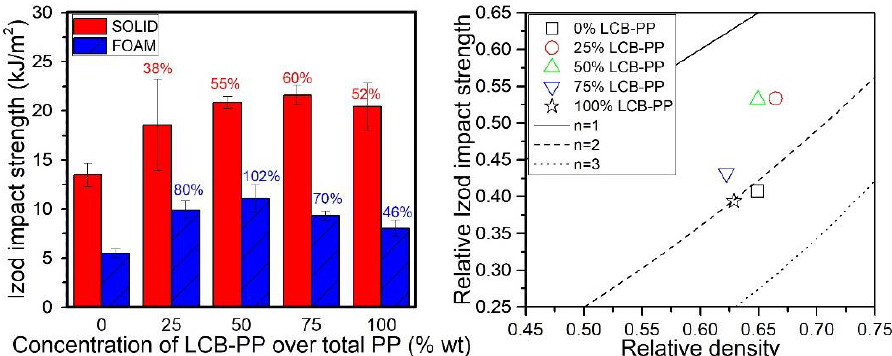
Figure 9. Izod impact strength of solids samples and foams ( left ) and relative Izod impact strength of foams in the scale model representation ( right ). The percentages in the left graph indicates the percentage of improvement of this sample with respect to the 0% LCB-PP compound value, for solids ( red ) and foams ( blue ).